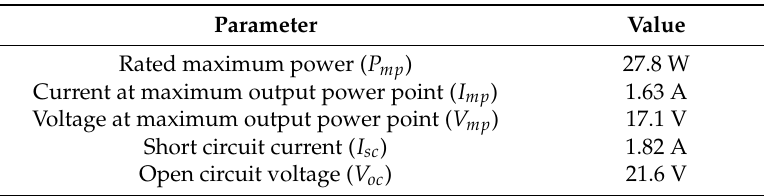
Table 5. Specifications of Sanyo HIP2717 module.